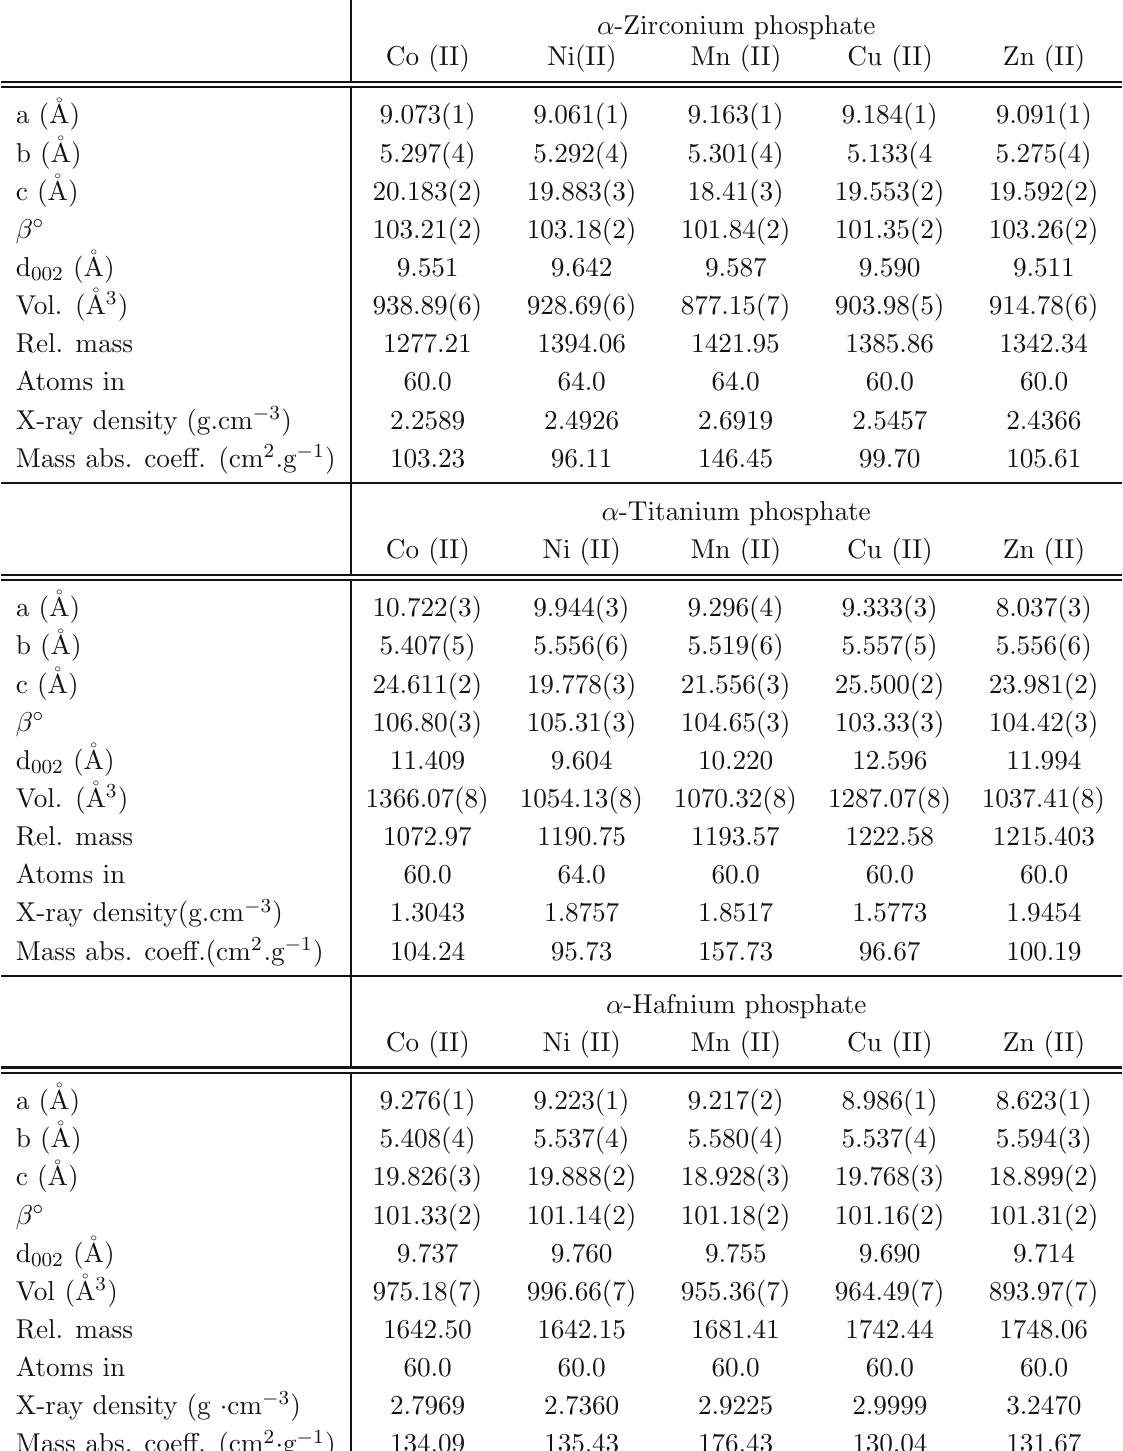
Table 9 Unit cell parameters of transition metal containing tetravalent metal